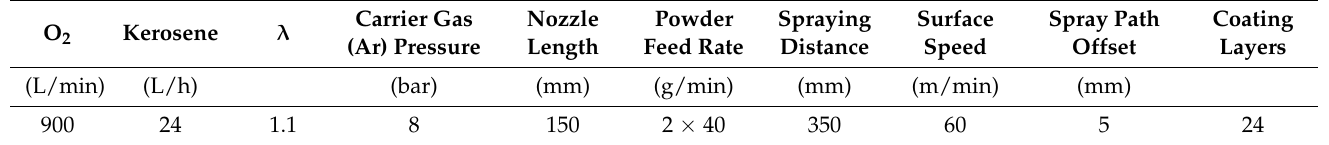
Table 2. Process parameters for the production of HVOF coatings.